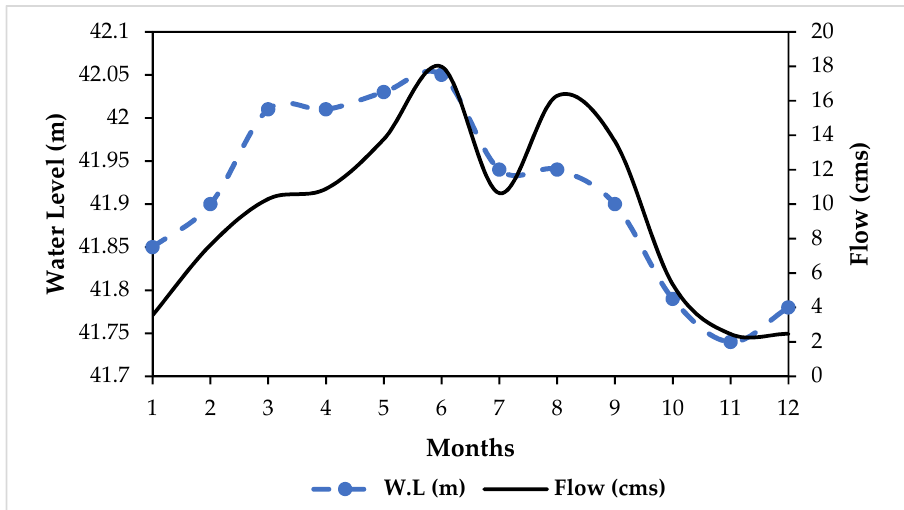
Figure 2. The monthly average river flows and water levels of Fèngsh ā n River at Xinpu Bridge.